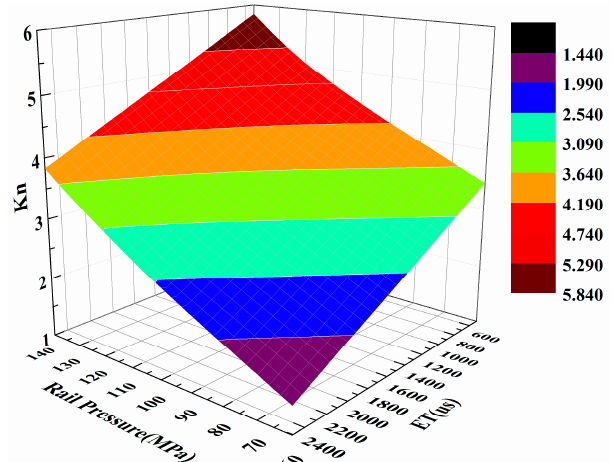
Figure 7. K n distribution at different rail pressures and ET.